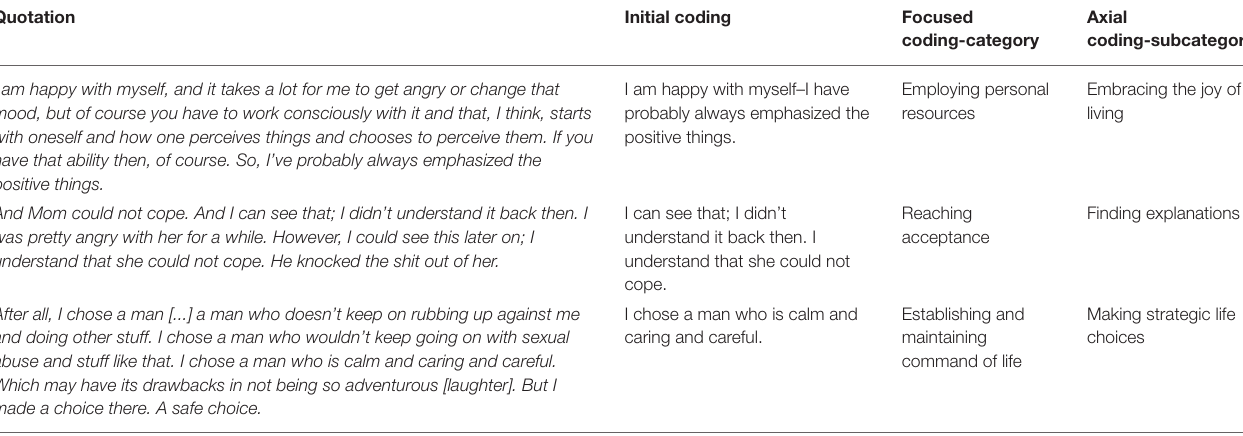
TABLE 1 | Example of the coding procedure. Quotation Initial coding Focused